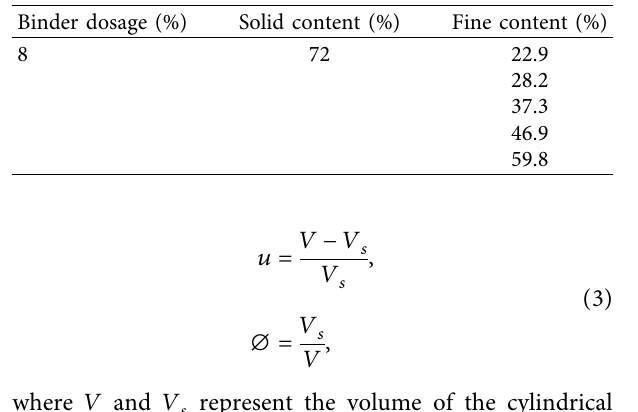
Table 2: Experimental program.